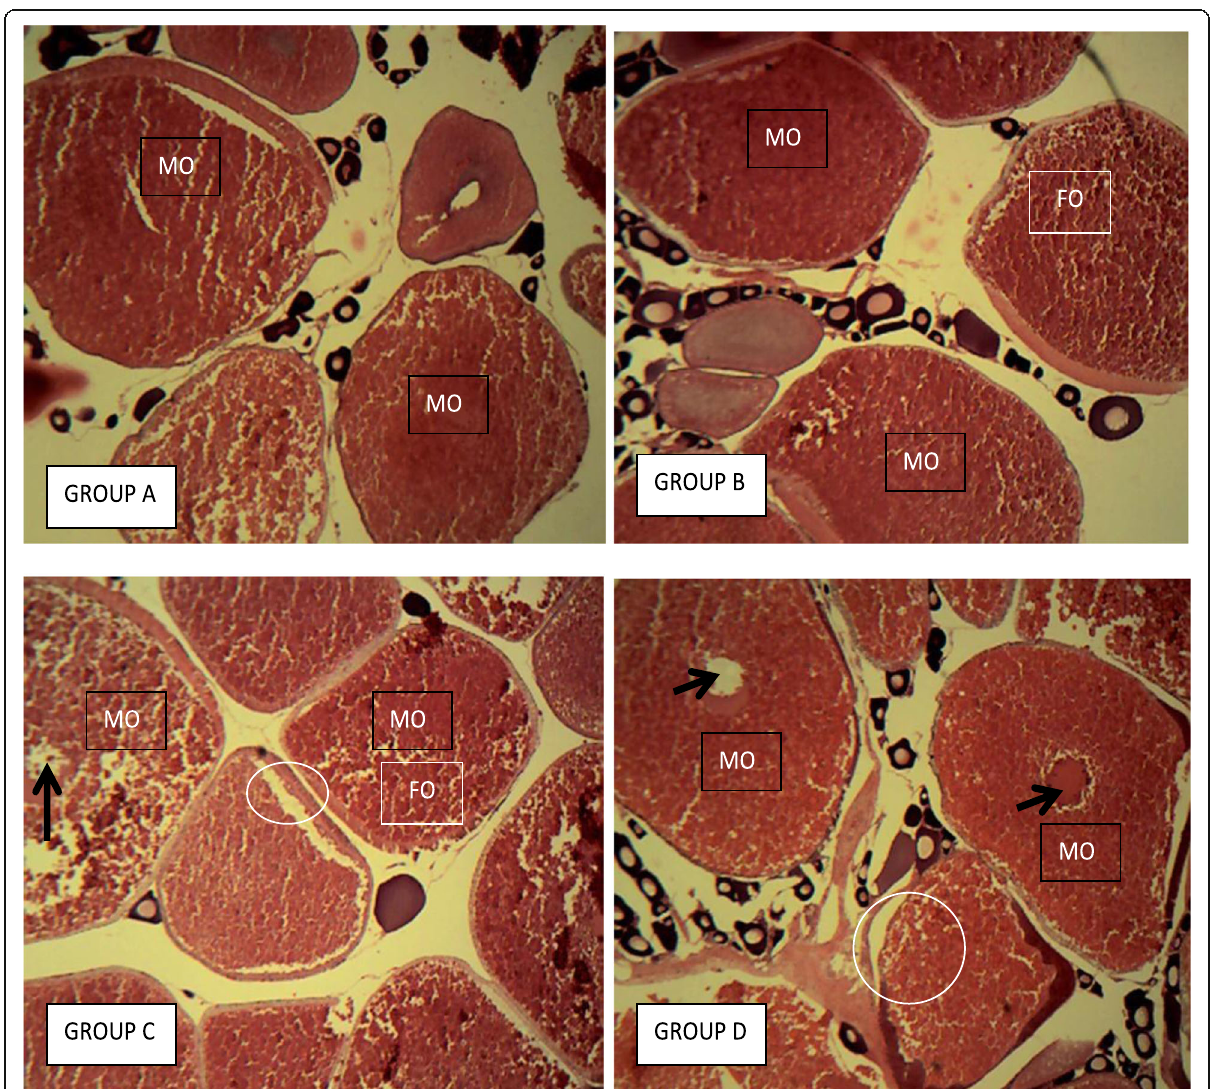
Fig. 6 Histopathology of the ovary of C. gariepinus exposed to different concentration of lambda-cyhalothrin on day 14. Group A (control), B (2.5 × 10 − 4 μ g/L), C (5.0 × 10 − 4 μ g/L), and D (8.25 × 10 − 4 μ g/L) (MO, mature oocyte; FO, flabby oocyte; white circle, degenerative ovarian changes; black arrow, vacuolation; H&E; Mag. ×